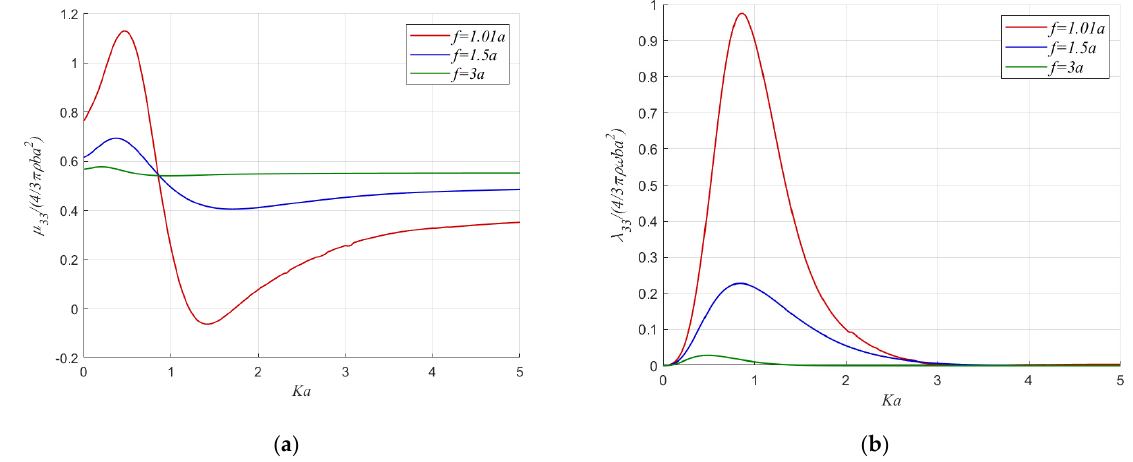
Figure 8. Normalized hydrodynamic coefficients in surge for a/b = 1.1, h = 10a: ( a ) added mass; ( b ) hydrodynamic damping.